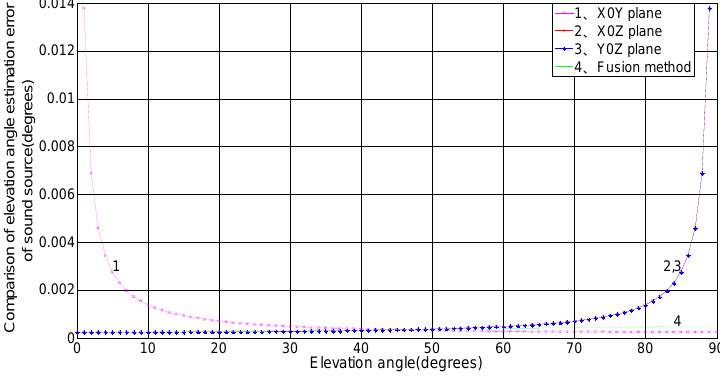
Figure 2. Comparison and analysis of the elevation angle estimation error of the sound source.